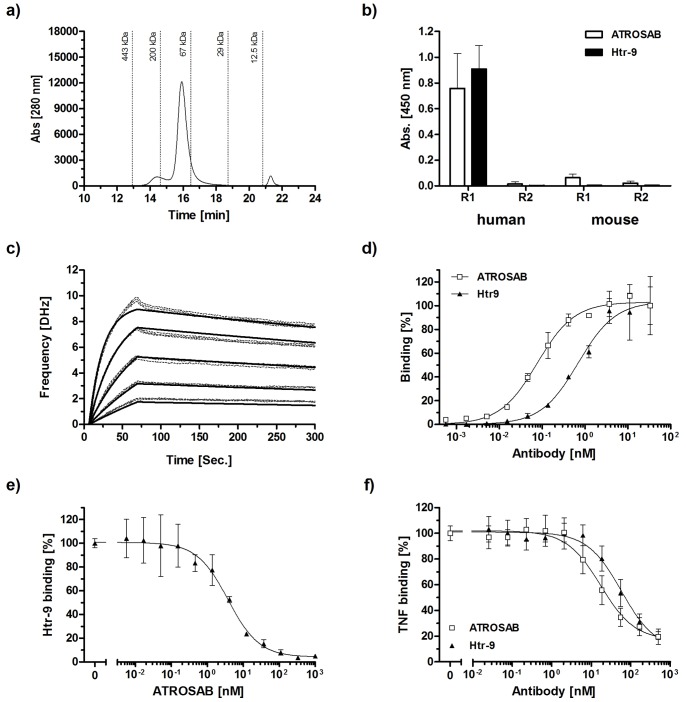
Characterization of the agonistic antibody Htr-9.a) SEC of purified Htr-9. b) ELISA analyzing binding of Htr-9 and ATROSAB to immobilized human and mouse TNFR1-Fc and TNFR2-Fc. c) Binding of Htr-9 to human TNFR1-Fc analyzed by QCM at a medium receptor density (indicated by a 48 Hz resonance frequency shift). Htr-9 was analyzed at concentrations between 1 µM–62.5 nM. d) Binding of ATROSAB and Htr-9 to immobilized human TNFR1-Fc in ELISA. e) Inhibition of binding of Htr-9 (7 nM) to human TNFR1-Fc by increasing concentrations of ATROSAB. f) Inhibition of binding of TNF (1 nM) to immobilized human TNFR1-Fc in ELISA by increasing concentrations of Htr-9 or ATROSAB, respectively.